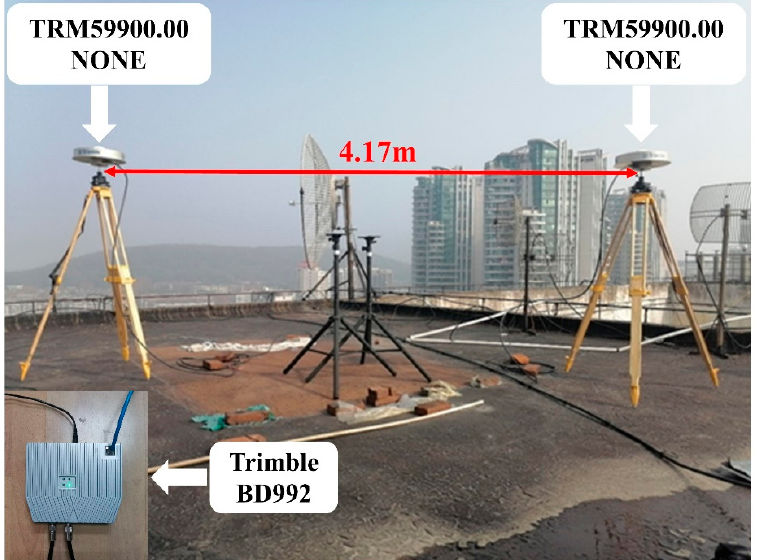
Figure 1. Observational equipment and condition.